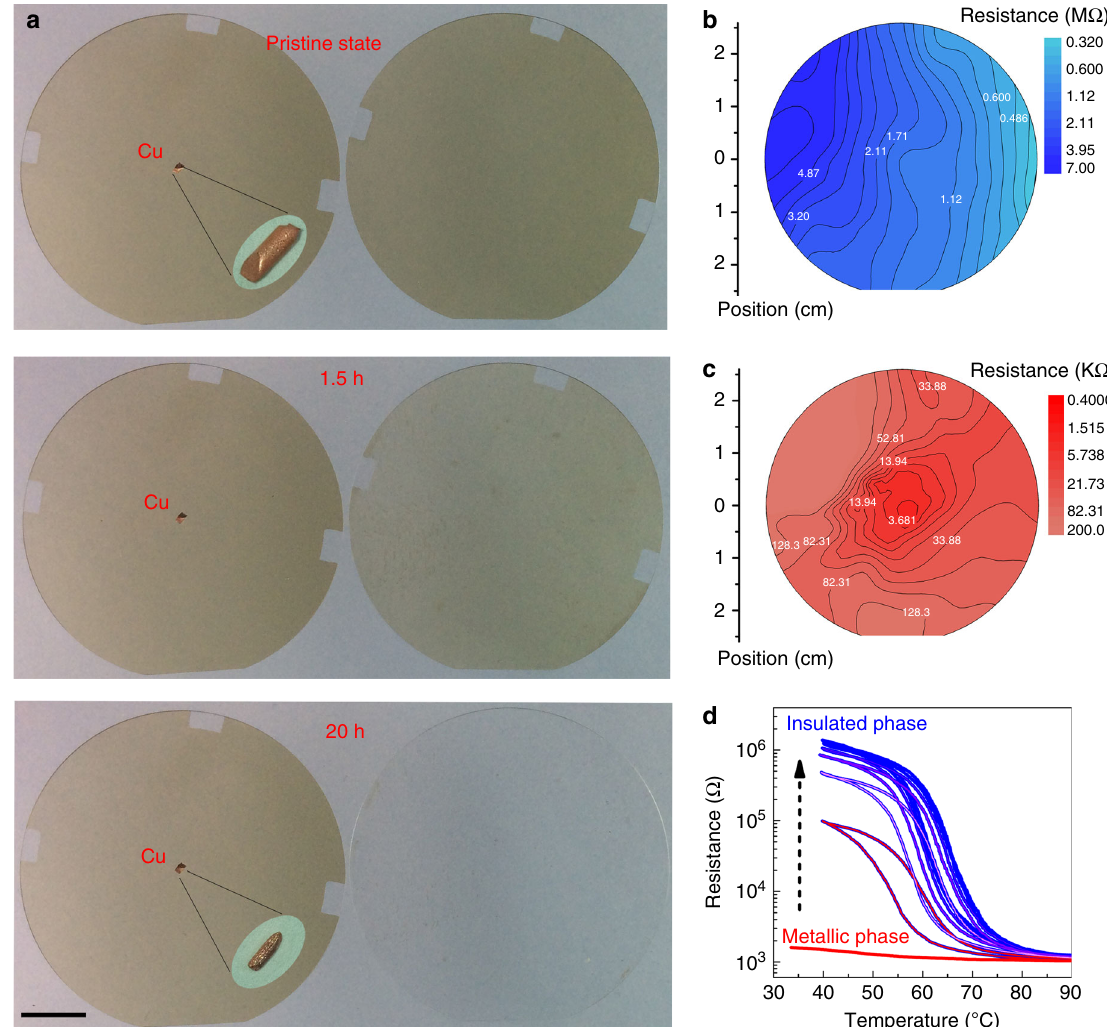
Fig. 2 Hydrogenation of a wafer-size VO 2 fi lm with a tiny Cu particle. a The two 2-inch VO 2 /Al 2 O 3 wafers immersed in 2%wt H 2 SO 4 acid solution. The sample with a tiny copper (Cu) particle (~1 mm) attached on the center surface exhibits pronounced anti-corrosion ability, whereas the bare VO 2 /Al 2 O 3 fi lm is completely corroded within 1.5 – 3 h, leaving the transparent Al 2 O 3 substrate. The scale bar is 1 cm. b The resistance mapping for the 2-inch pristine VO 2 fi lm. c The resistance mapping for the metal(Cu)-acid-treated VO 2 . For the whole 2-inch wafer, the surface resistance is decreased by almost three orders of magnitude in comparison to the pristine fi lm, re fl ecting the MIT of M-VO 2 by hydrogenation. d The resistance measurement in air for the metal (Cu)-acid-treated M-VO 2 as the function of heated temperature. Along with the pronounced hysteresis R – T curve, the metallic sample gradually recovers to the initial insulated M-phase VO